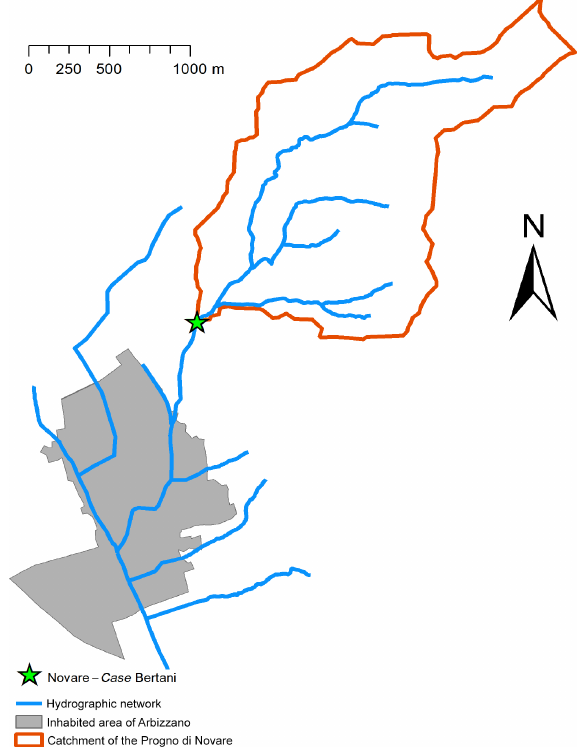
Figure 2. Map of the Progno di Novare (catchment in orange) with its outflow at Case Bertani and of Arbizzano (in grey), where most of the flash flood damage was